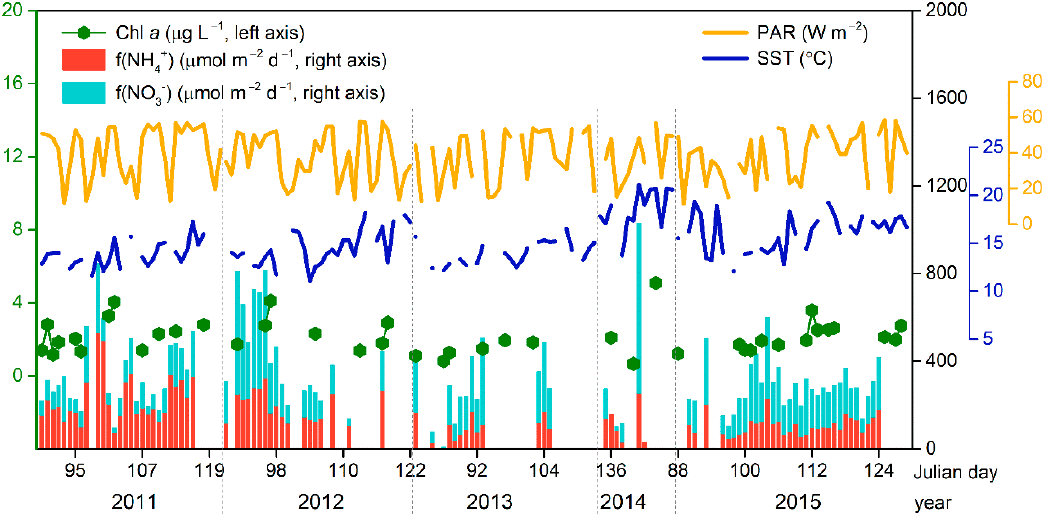
Figure 5. The average values of Chl a , PAR, and SST in R3 corresponding to aerosol dry deposition fluxes of NH 4 + and NO 3 − during the studied period.